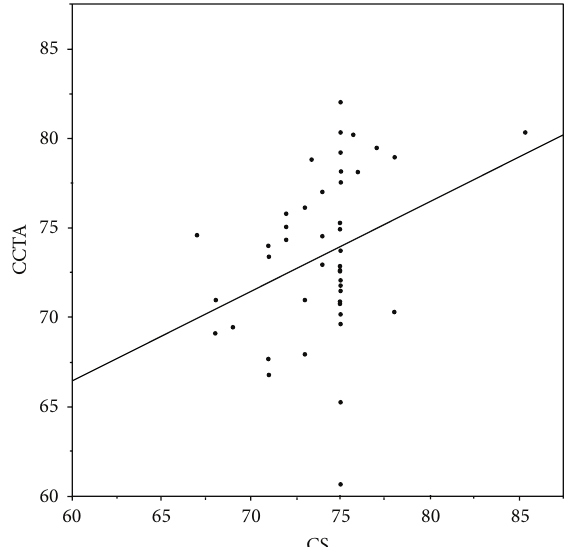
Table 2: Scanning parameters. Figure 2: Scatter plot comparing the calcium scoring (CS) scan and coronary computed tomography angiography (CCTA) diagnostic phases for each patient. The line represents predictive formula for